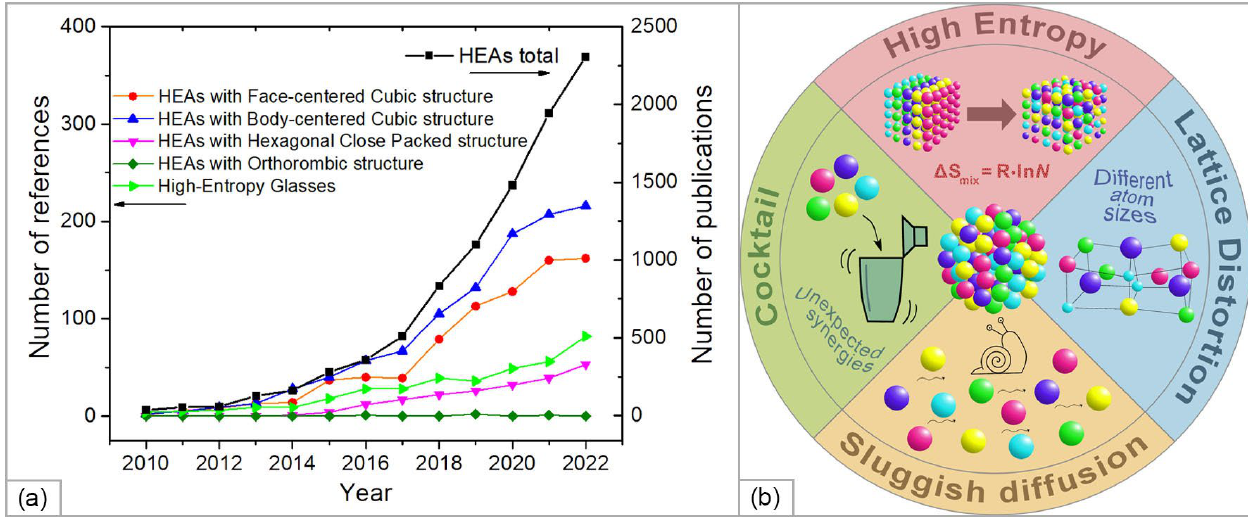
Figure 1. ( a ) Recent publications on the development and application of high-entropy alloys (HEAs) of different structures (for 2010–2022 years, according to the Scopus data); ( b ) schematic illustration of the properties and characteristics of HEAs.